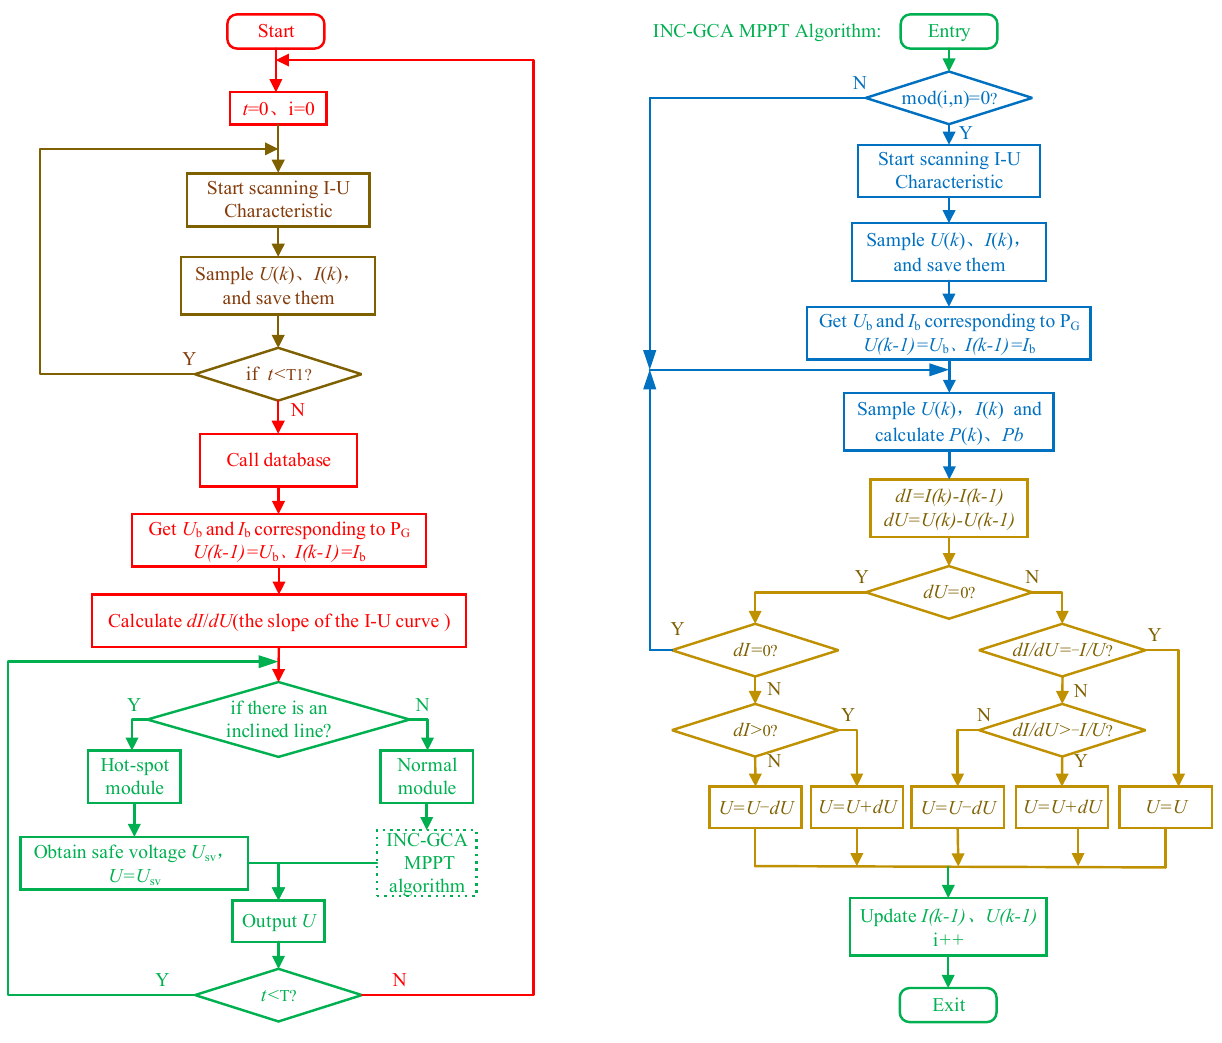
Figure 8. Flow chart of PV module low resistance hot-spot diagnosis and suppression control algorithm based on I-U characteristic analysis.